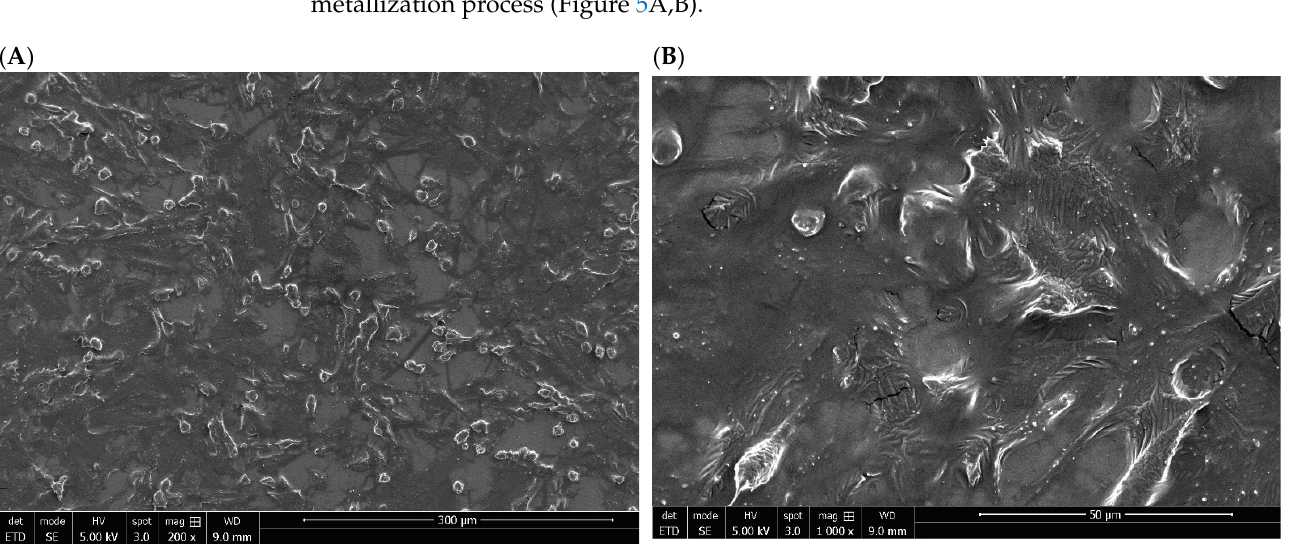
Figure 4. SEM image of SaOs-2 bone cells seeded on the surface of S_TiCp (mirror polished) disc at initial magnification of 300× ( A ) and 1000× ( B ) after a 72-h-incubation period. On the mirror-polished surface of S_TiNb discs, cultured SaOs-2 cells also displayed